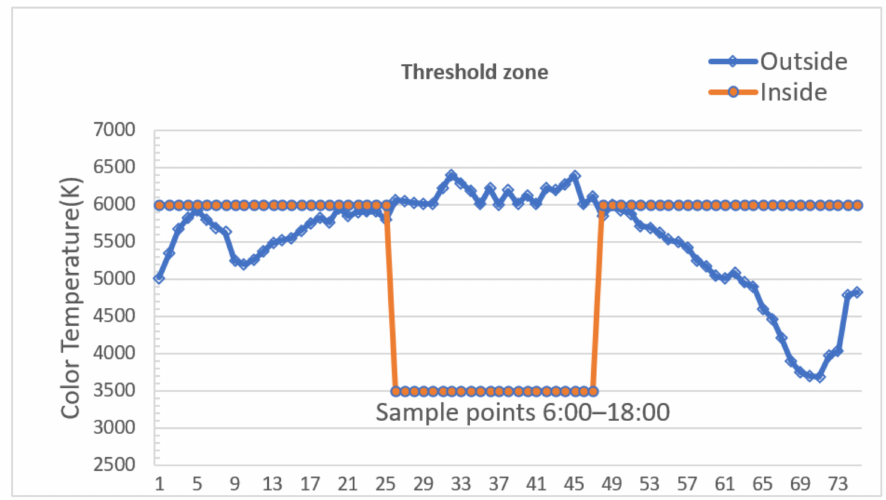
Figure 9. Color temperature curve in a threshold zone.